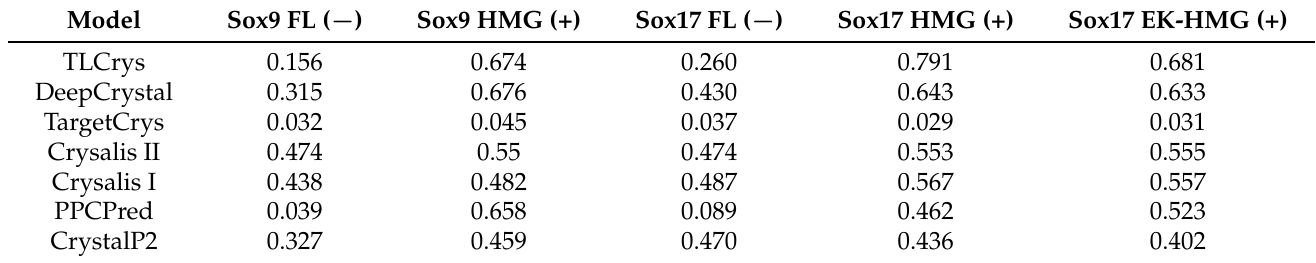
Table 5. Predicted probability value of the TLCrys and other predictors for Sox transcription fac- tor